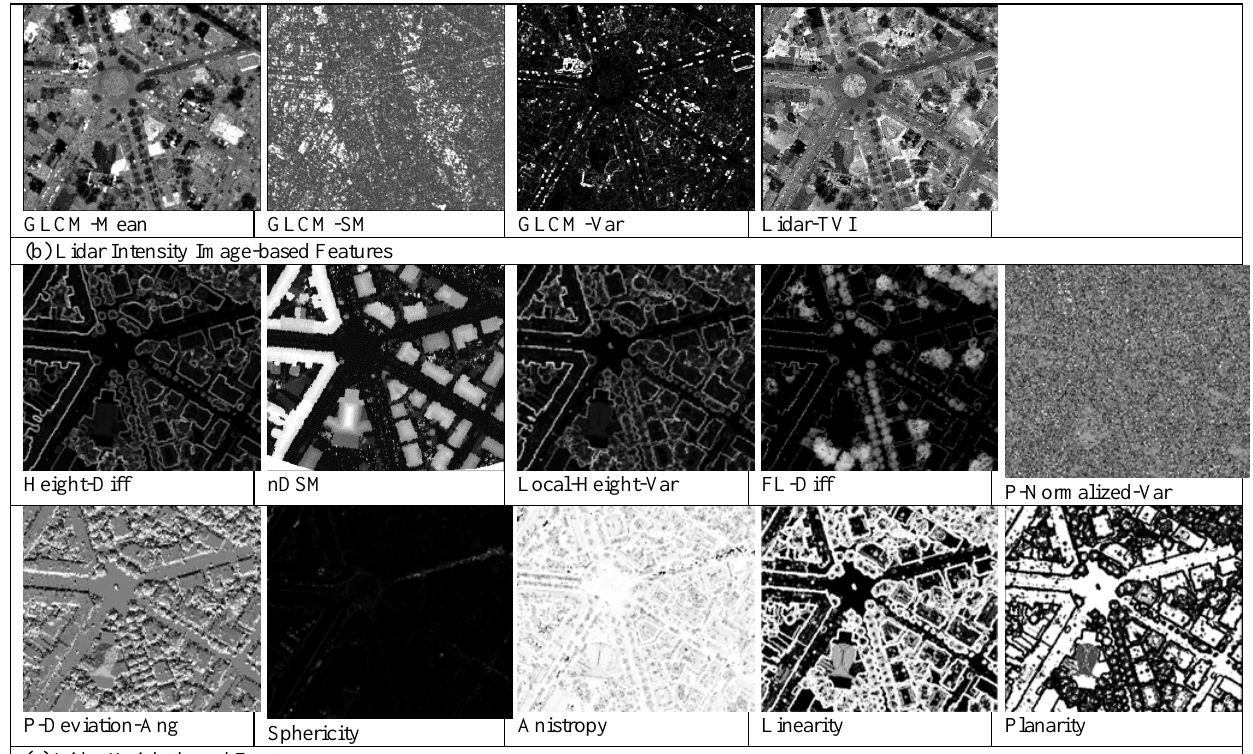
Figure 2. Overview of features from lidar and